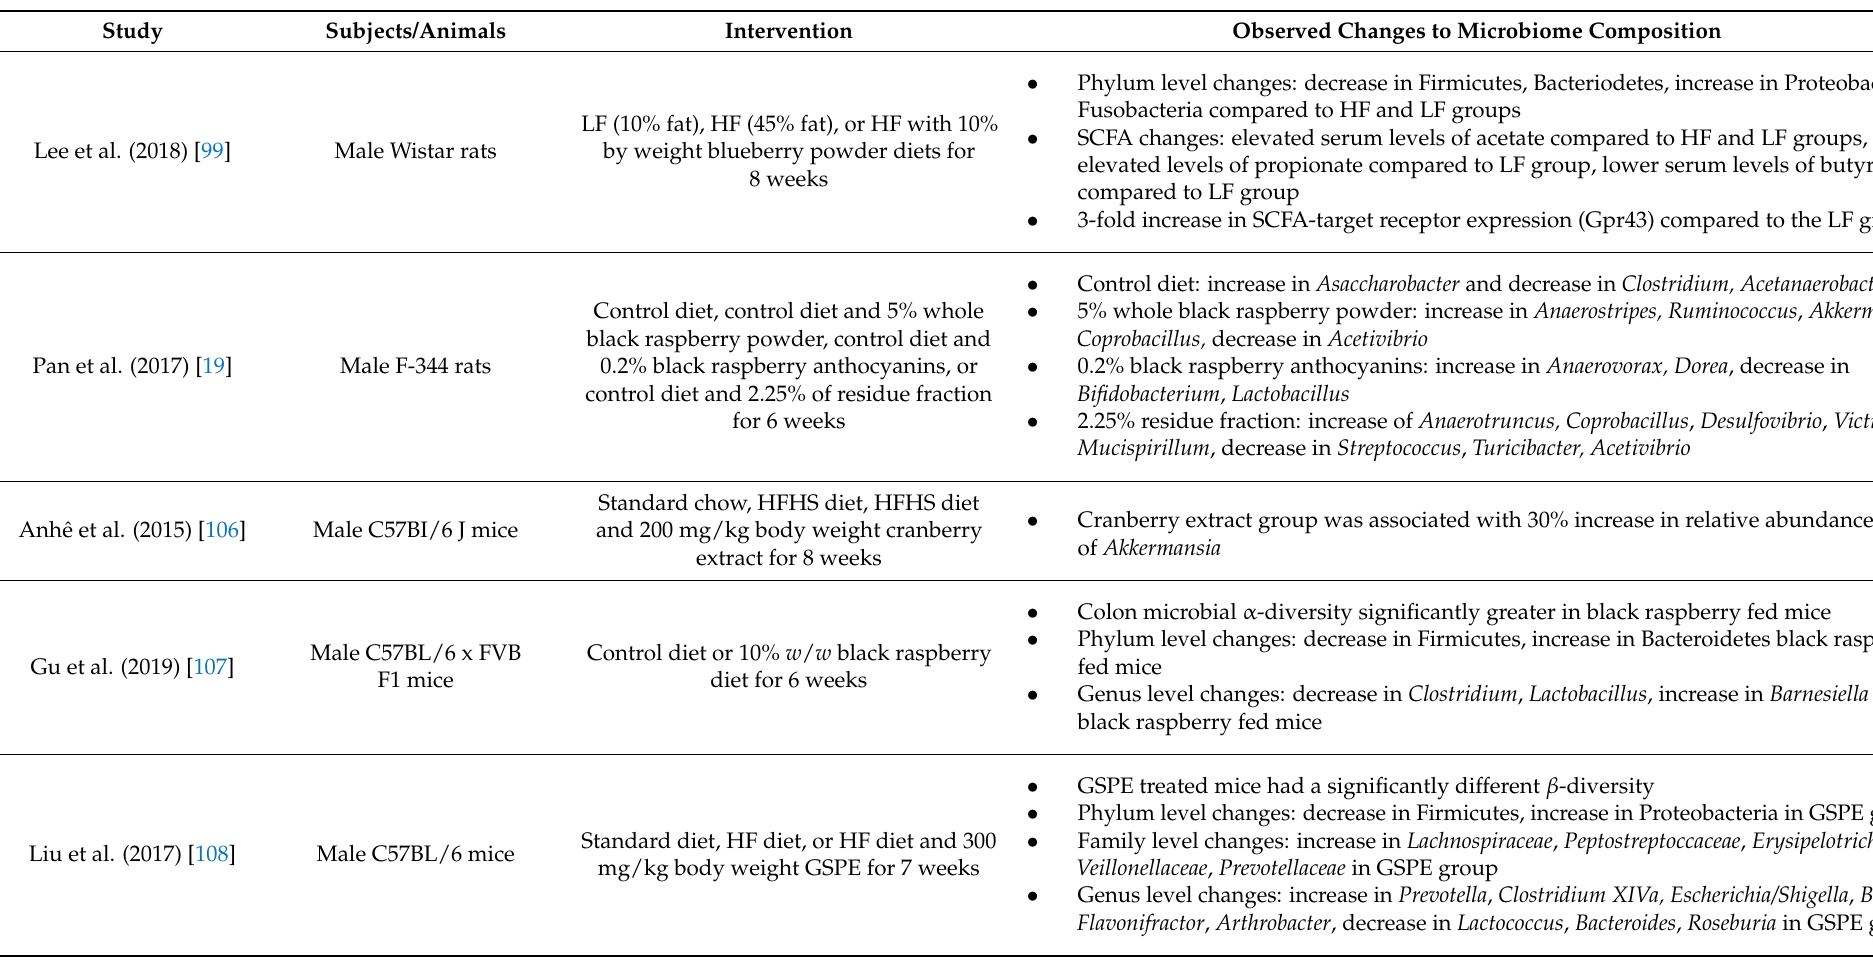
Table 2. Significant gut microbiome alterations following consumption of anthocyanin rich foods a